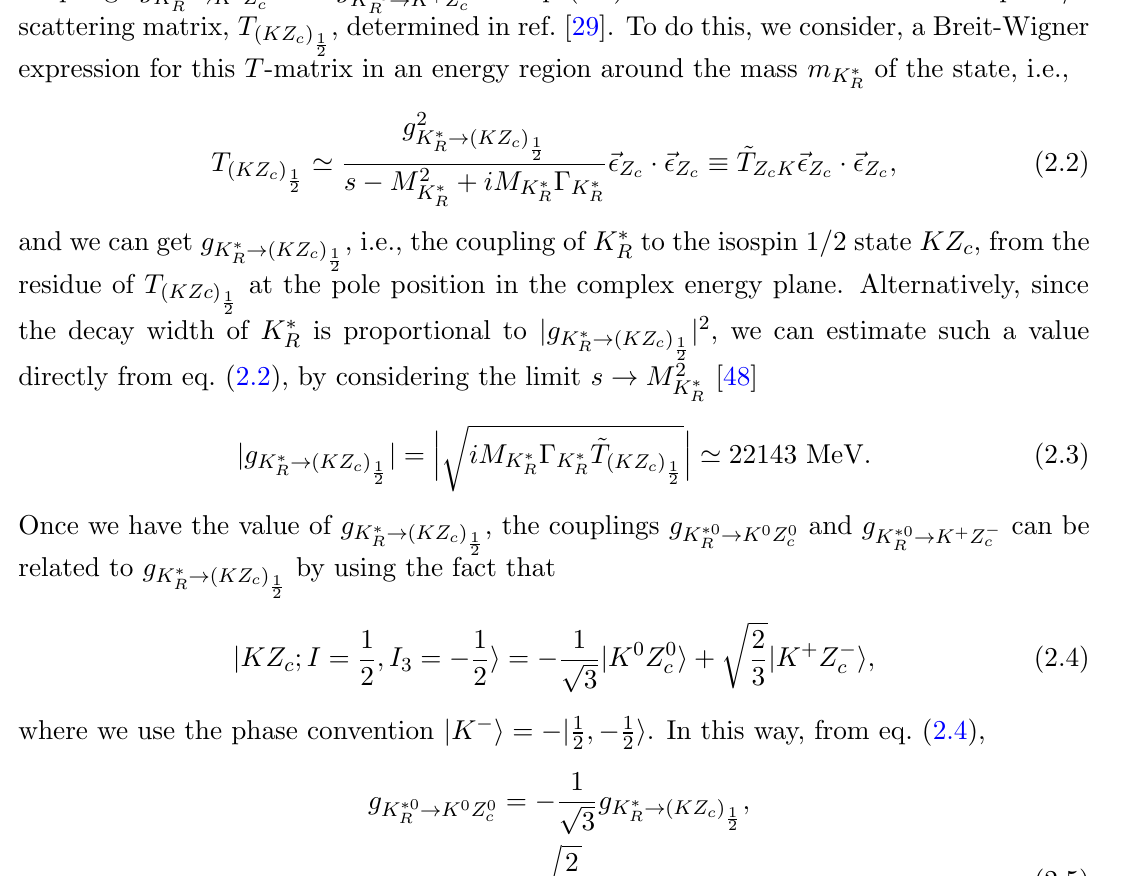
to the KZ (3900) channel c R